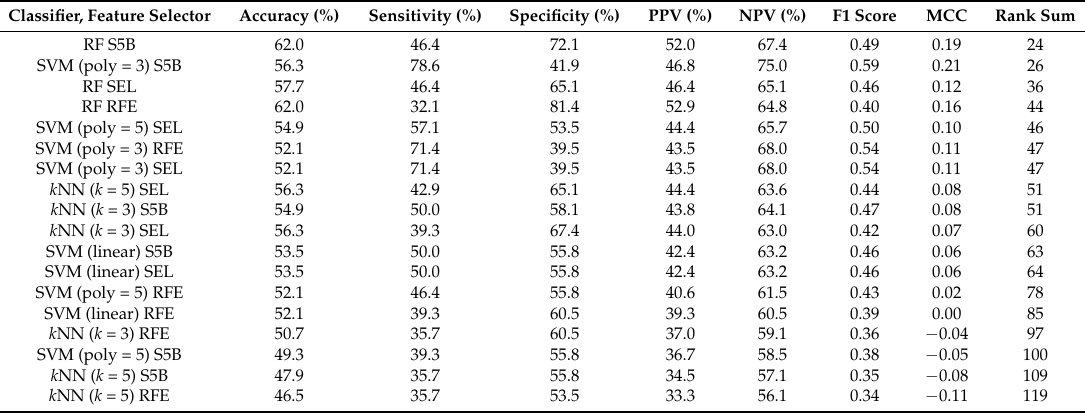
Table 1. Straight-walking section five-fold cross validation (5FCV) results. PPV: positive predictive